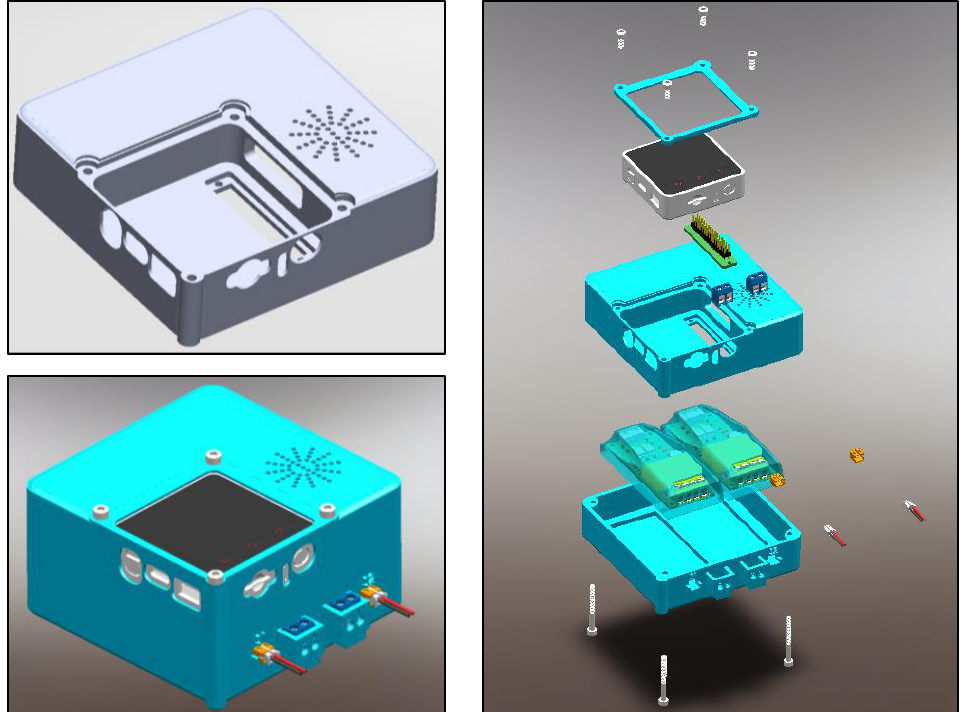
Figure 5. Case design for the electrical parameters monitor.